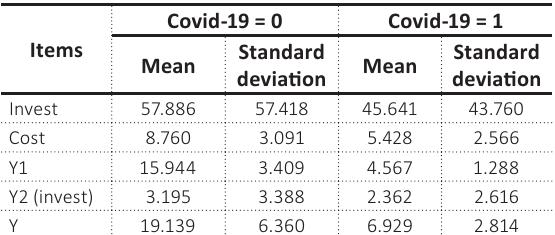
Table 2. The descriptive statistics